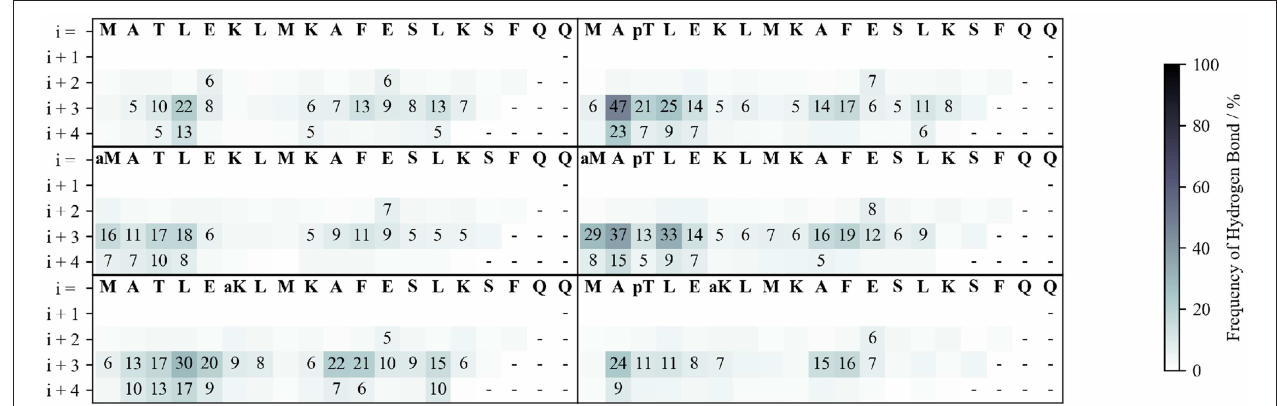
FIGURE 3 | Frequency of backbone hydrogen bond formation. The hydrogen bonds between the carbonyl of each residue (labeled in the 1st row) with the amide proton of each of the following four residues (rows) are shown.